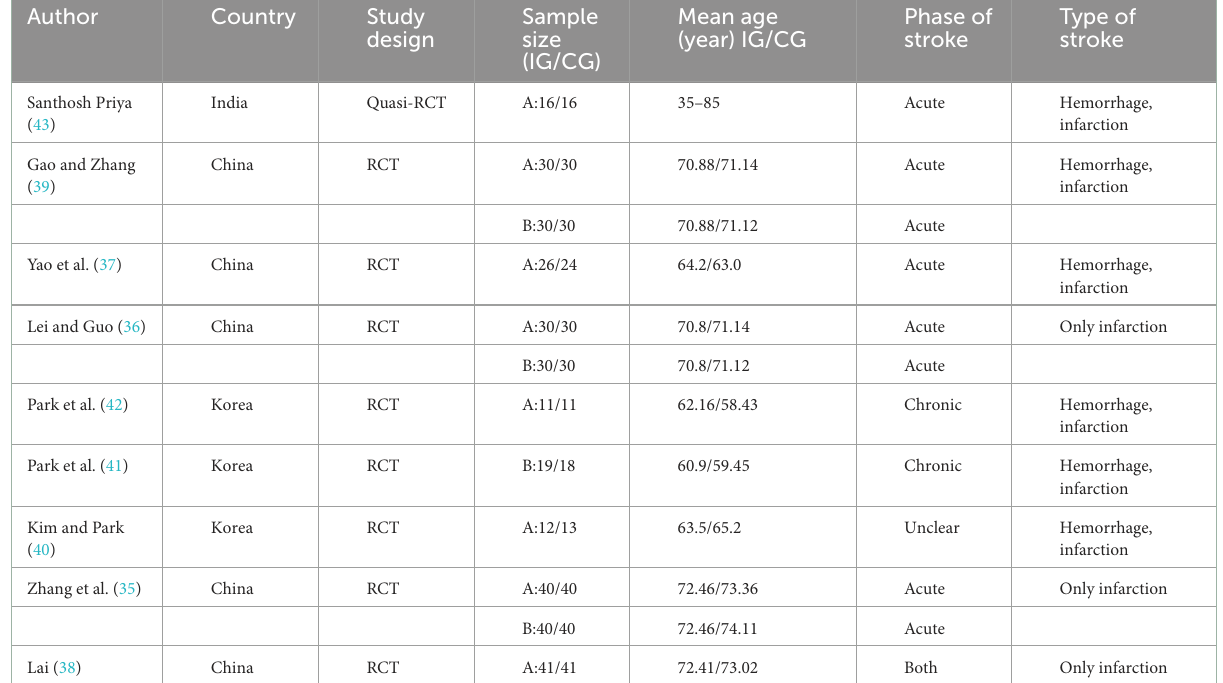
TABLE 1 Characteristics of participants in the included